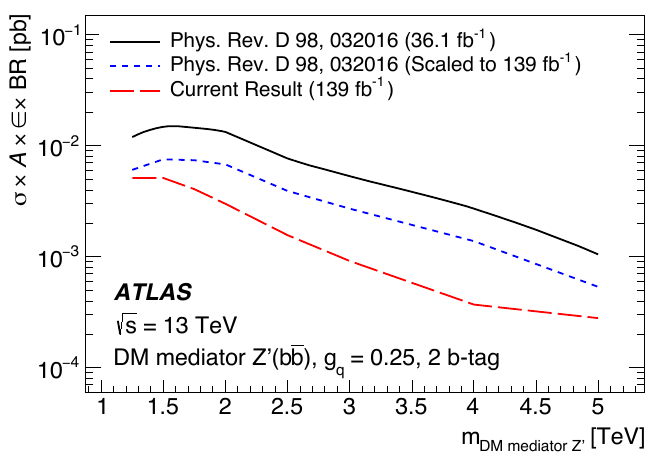
Figure 9 . The expected 95% CL upper limits on the cross-section times acceptance times b - tagging e(cid:14)ciency times branching ratio as a function of the DM mediator Z 0 mass for the